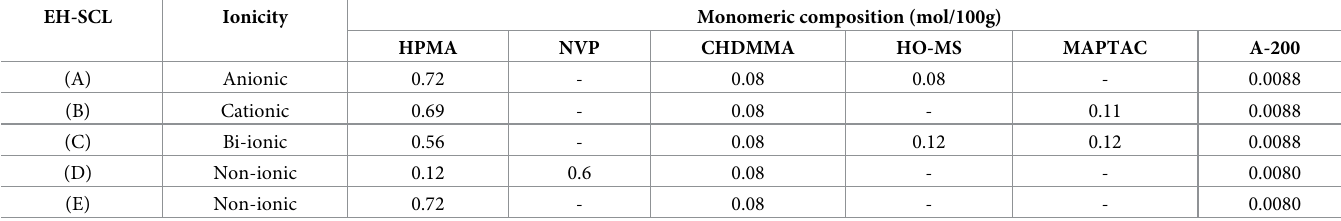
Table 1. Monomeric composition of the soft contact lenses with different ionicities. EH-SCL